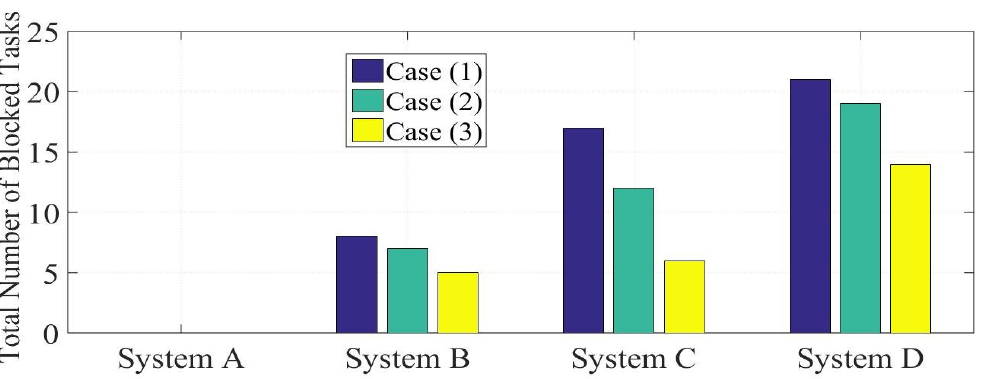
Figure 14. Total number of blocked tasks for the four considered systems in case (II) of the second simulation scenario. Table 11. Percentage of blocked tasks for the four considered systems in case (II) of the second scenario.